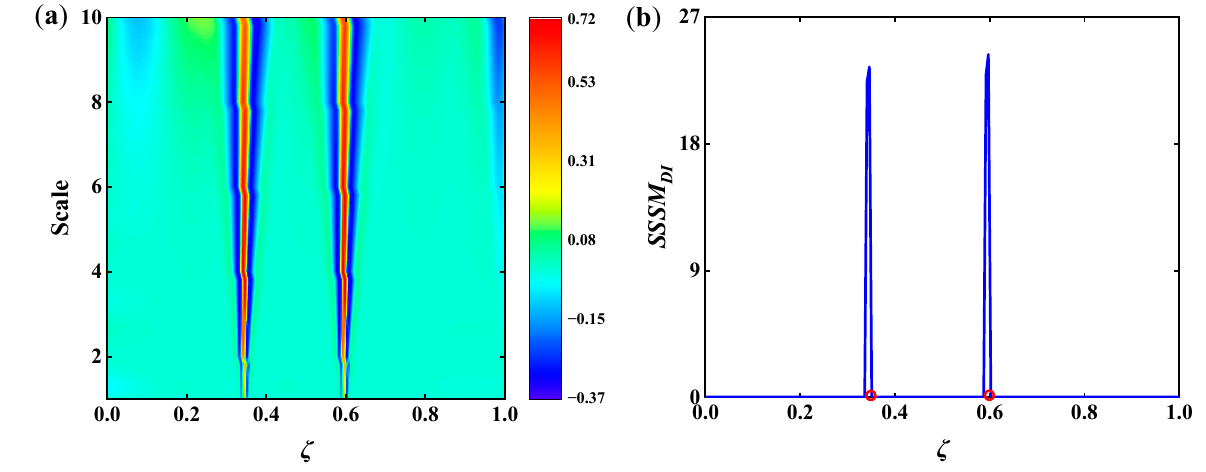
Figure 13. Damage identification results under scenario I: ( a ) CS (cid:3364)(cid:3364)(cid:3364)(cid:3364) ( b , s ); ( b ) Damage index SSSM